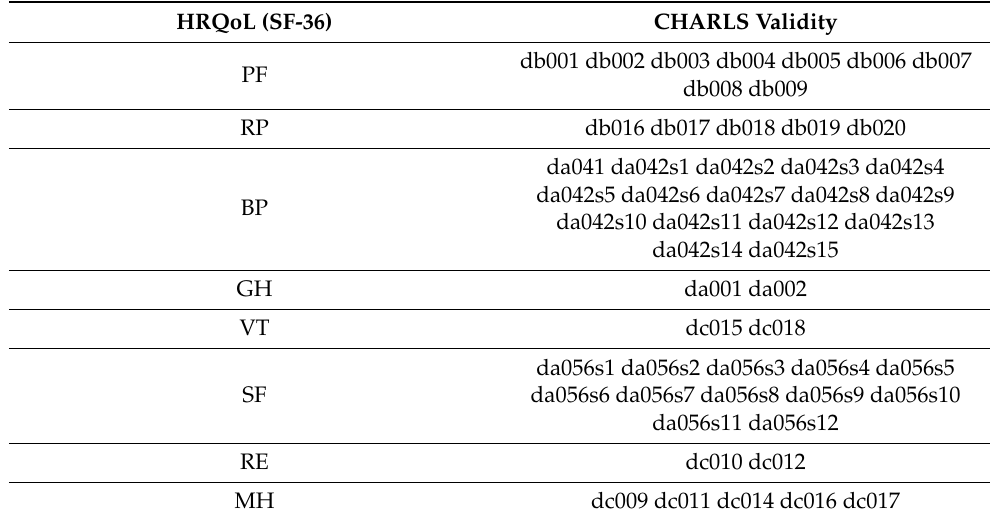
Table 2. Corresponding variables in the CHARLS